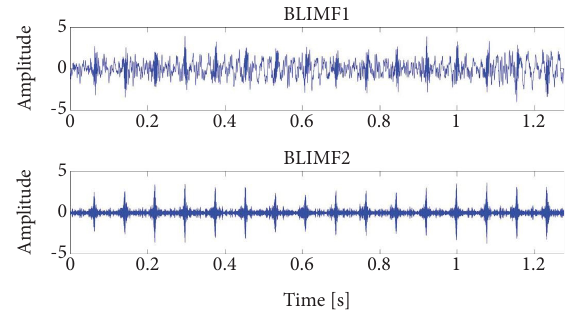
Figure 8: Two groups of BLIMF components of end-stage VMD.